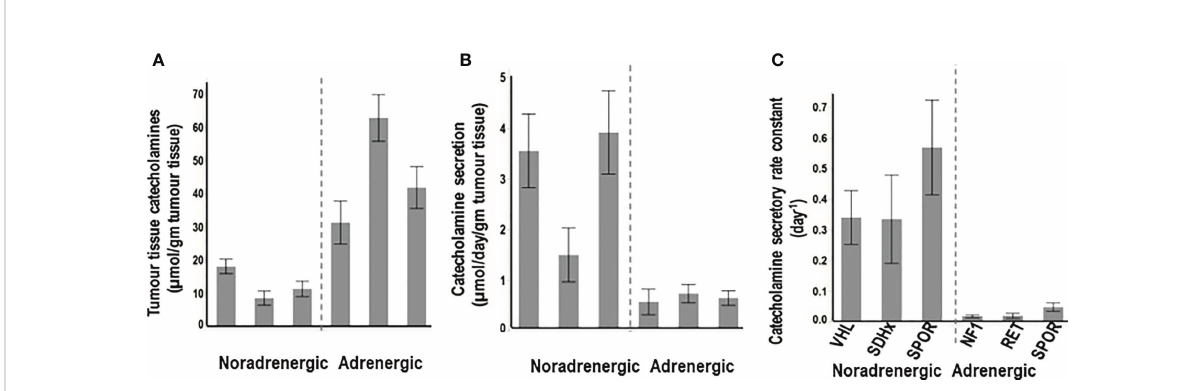
FIGURE 2 Tumor tissue contents of catecholamines (A) , rates of secretion of catecholamines from tumors (B) and catecholamine secretory rate constants (C) for PPGLs from patients with hereditary ( VHL, SDHx ), and sporadic (SPOR) noradrenergic tumors versus hereditary ( NF1, RET ) and sporadic (SPOR) adrenergic tumors. Secretory rate constants illustrate that for noradrenergic tumors over a third of all catecholamines in stores are secreted within one day, whereas for adrenergic tumors less than 5% of stores are secreted within one day. ( Reproduced with permission from Eisenhofer G et al. Clin Biochem Rev 2017